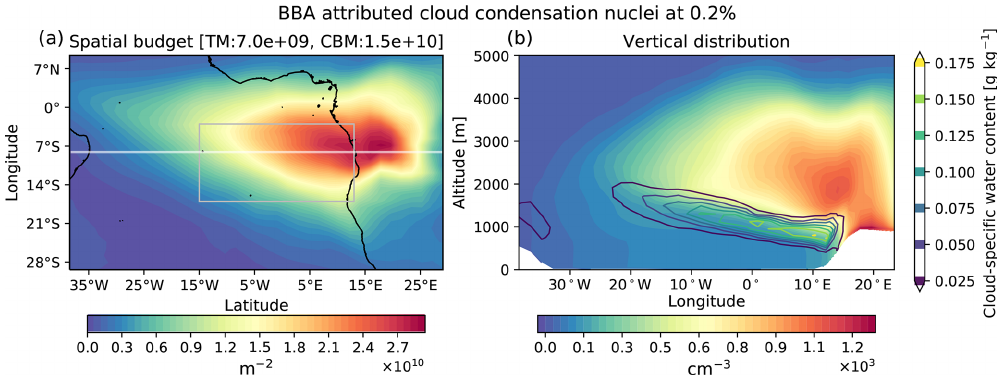
Figure 4. UKESM1-simulated mean cloud condensation nuclei attributed to BBA at 0.2% supersaturation under standard conditions for temperature and pressure (STP) during July and August 2016–2017 as (a) the vertically integrated burden and (b) profile along the latitude of Ascension Island, 8.1 ◦ S (the white line in Fig. 3a). The domain in Fig. 3a, ranging from 30 ◦ S to 10 ◦ N and from 40 ◦ W to 30 ◦ E, is the area of interest in this paper. The grey box in the map (cloud box) represents the cloud areas where the averaged low cloud fraction is above 0.58. The TM is the total mean of the domain and the CBM is the mean of the cloud box. The contours in Fig. 3b are the cloud-specific water content in the baseline